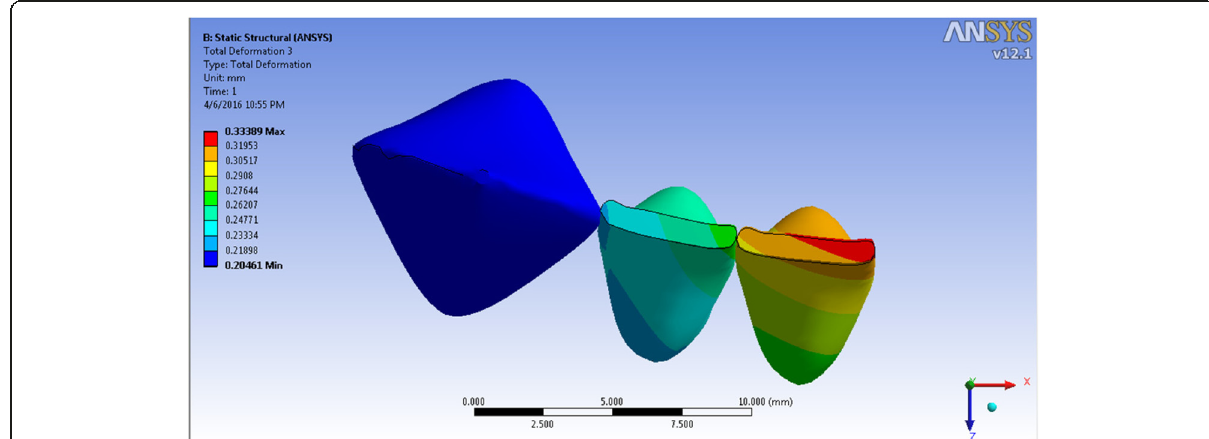
Fig. 5 Total deformation in the teeth of the first model (the inclination of the anterior teeth at 80° to the horizontal plane)